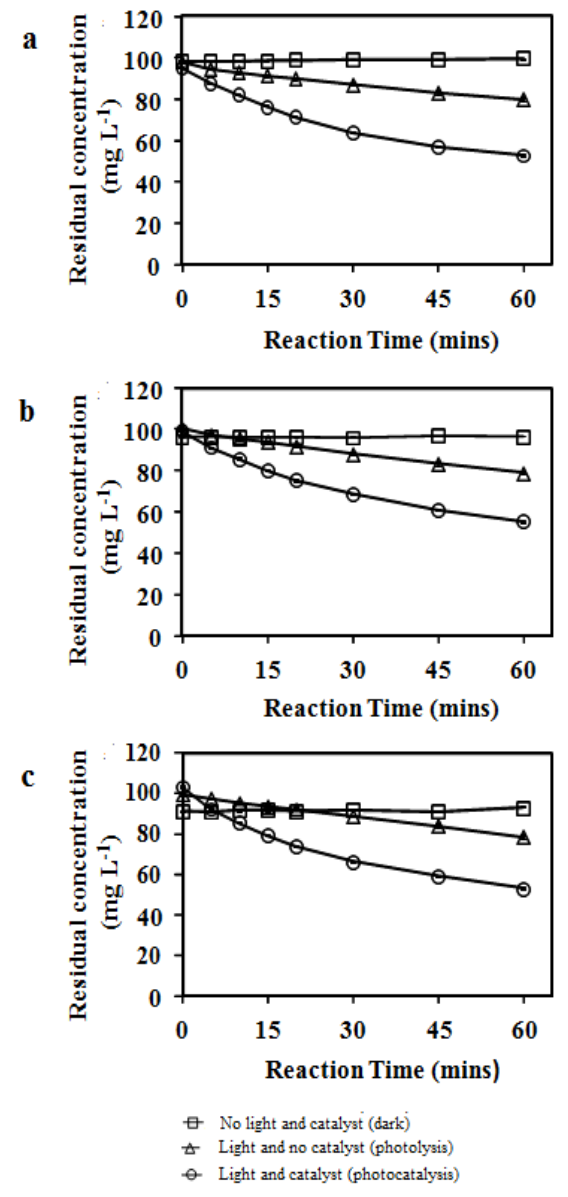
Figure 2. A comparison of the residual concentration profiles for phenol under the following conditions: ( a ) 5-nm TiO TiO particles. Temperature = 30 °C, and wavelength = 300 nm. Values are the average 2 and SD for triplicate